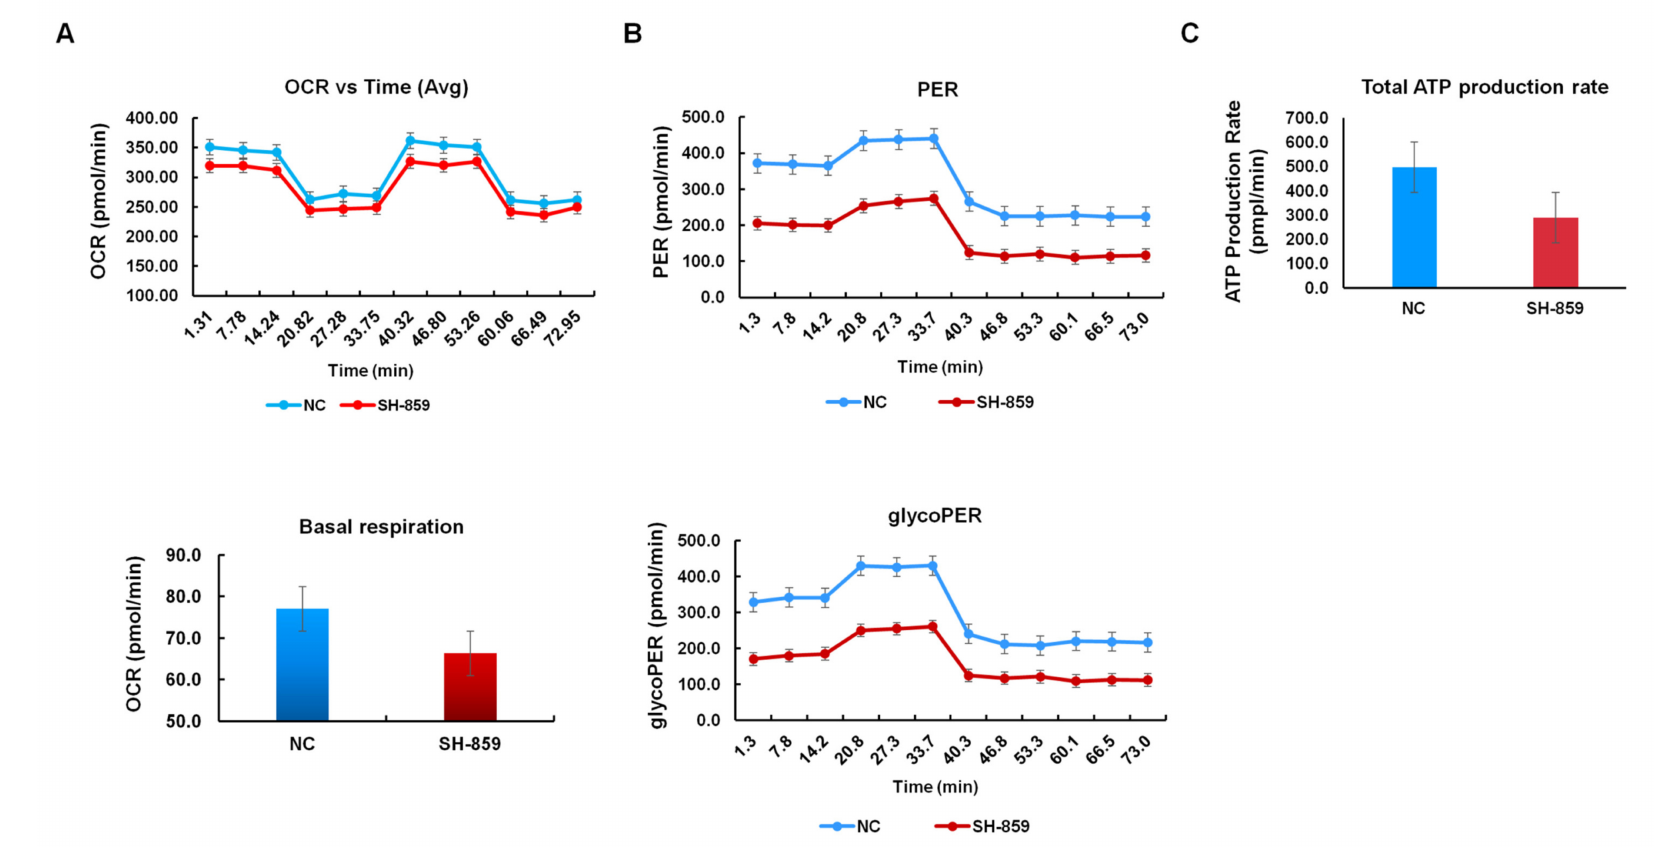
Figure 5. Attenuation of glycolysis in 786-O cells after SH-859 (15 µ M) treatment. ( A ) No important fluctuations were noticed in the oxygen consumption rate after SH-859 treatment. SH-859 treatment inhibited basal respiration. ( B ) Proton e ffl ux rate and proton e ffl ux rate by glycolysis were inhibited after SH-859 treatment. ( C ) SH-859 treatment significantly declined the total ATP production rate. Representative results of three independent experiments ( n = 3) are shown. NC: normal control (untreated 786-O